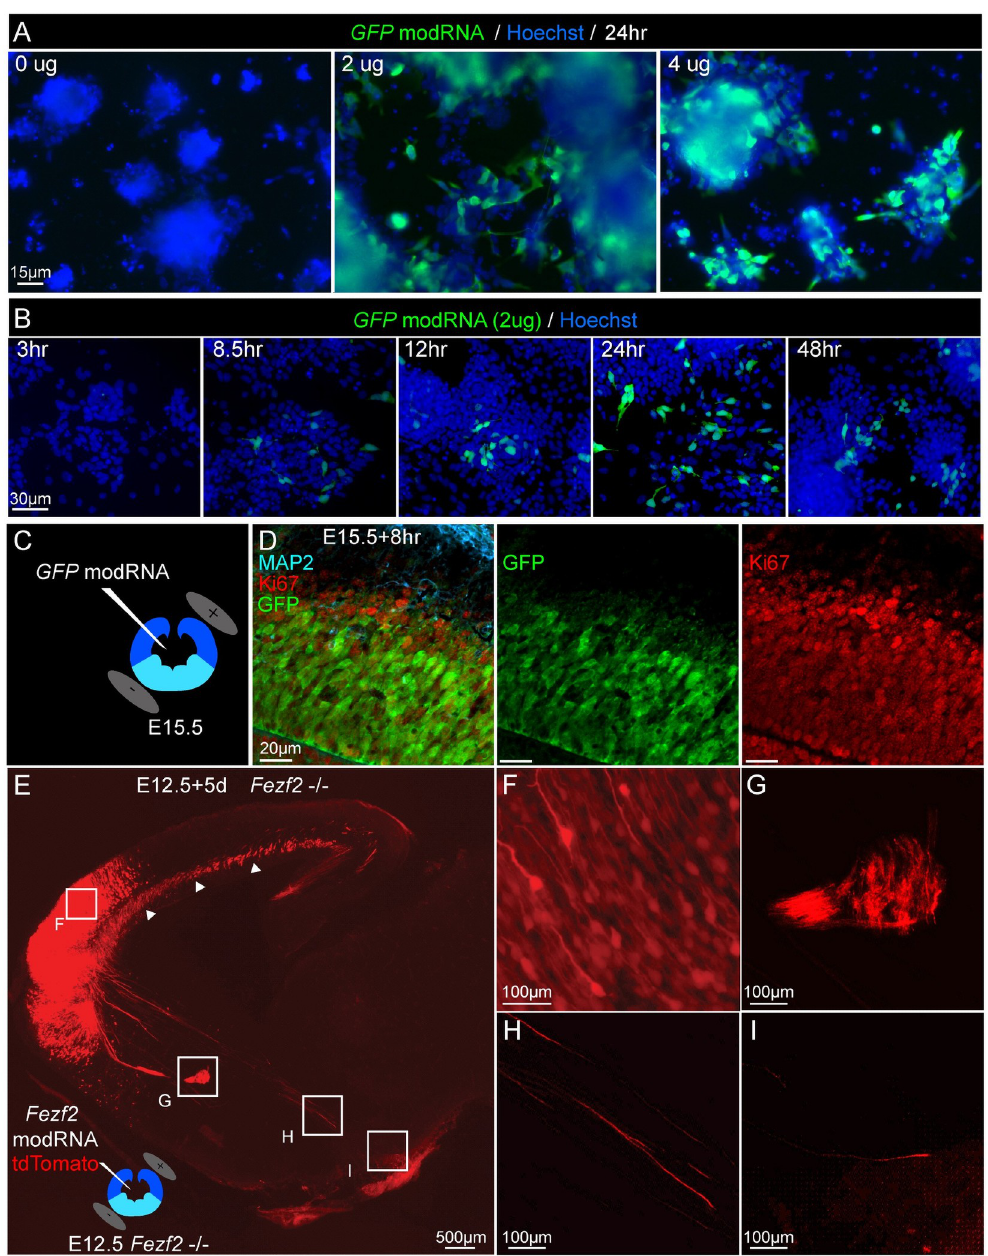
Fig 1. ModRNA enabled temporally controlled, dose-dependent protein expression in cultured mES-derived populations, and in vivo . (A) GFP modRNA expression was dose-dependent in mES-derived pallial-like progenitors at 14 days in vitro (DIV). Native GFP expression was detected in 25–50% of cells after 24hrs; the intensity of expression increased over the range of 0, 2, 4 microgram modRNA transfection. (B) GFP modRNA expression was time-dependent over 48hrs. (C) GFP modRNA was injected into the lateral ventricles (coronal cross-section of mouse embryo forebrain is shown) and directionally electroporated into the dorsal forebrain / pallium (positive paddle above dark blue colored tissue). (D) Following in utero electroporation of GFP modRNA (0.8 microgram / microliter), GFP protein (green) is expressed after eight hours, and is restricted to Ki67-expressing progenitors (red) of the pallium, not in more superficially located post- mitotic neurons, which express MAP2 (blue). (E) Sagittal section of an E17.5 Fezf2 -null mouse following E12.5 in utero electroporation of Fezf2 modRNA (0.8 microgram / microliter) and tdTomato plasmid (1 microgram / microliter) showed targeted tdTomato fluorescence appropriately restricted to the rostral pallium. (F) Higher magnification image showing tdTomato expression in the cortical plate. (G) tdTomato+ axons projected across the cerebral commissures, including anterior commissure (depicted) and corpus callosum in (arrowheads in E). (H) Several tdTomato+ axons projected caudal to